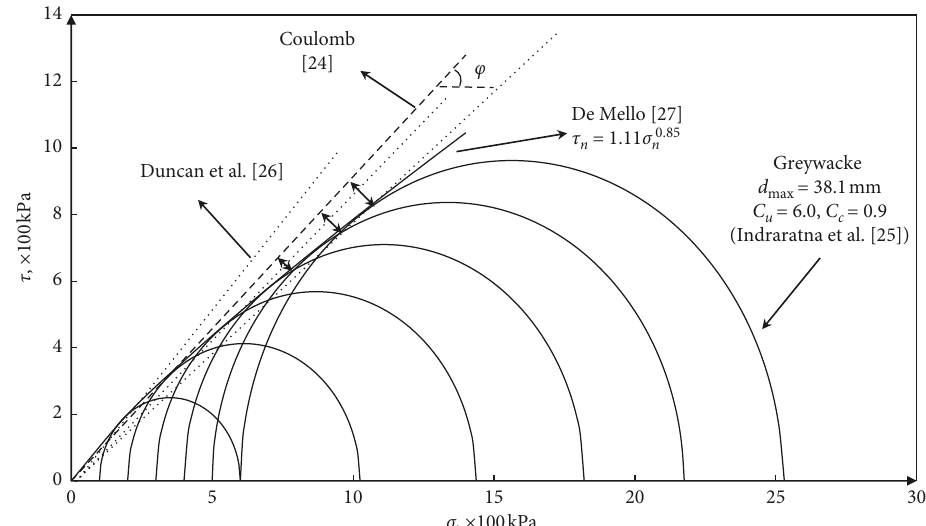
Figure 4: Several expressions of the shear strength of cohesionless soils (experimental data from Indraratna et al.